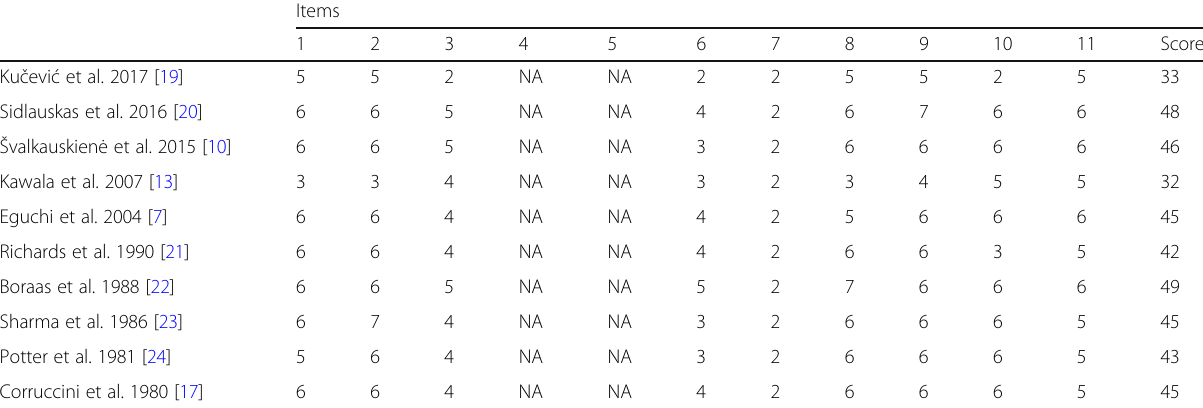
Table 2. Quality assessment scores for the selected studies based on the quality of genetic association studies (Q-Genie) Items